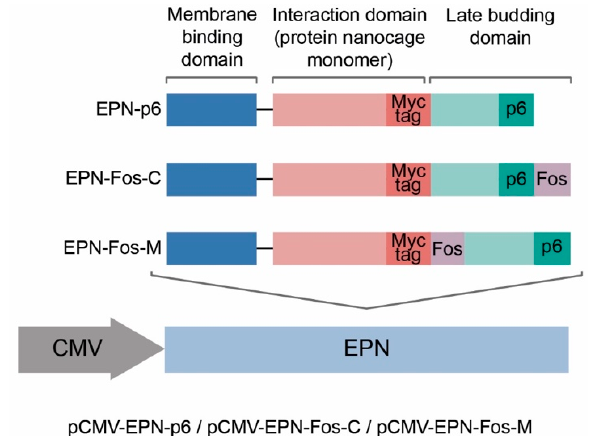
Figure 1. Construction of the pCMV-EPN vectors. Each EPN monomer consists of 3 functional domains: Membrane binding, Interaction and Late budding domain. EPN-Fos-C and EPN-Fos-M include additional Fos domain at the C-terminal of protein sequence and at the N-terminal of the Late budding domain, respectively. Fos domain provides active loading of EPN nanocages with the protein of interest fused with Jun domain. (The analogic constructs with T7 promoter were obtained in pET22-based prokaryotic vector).